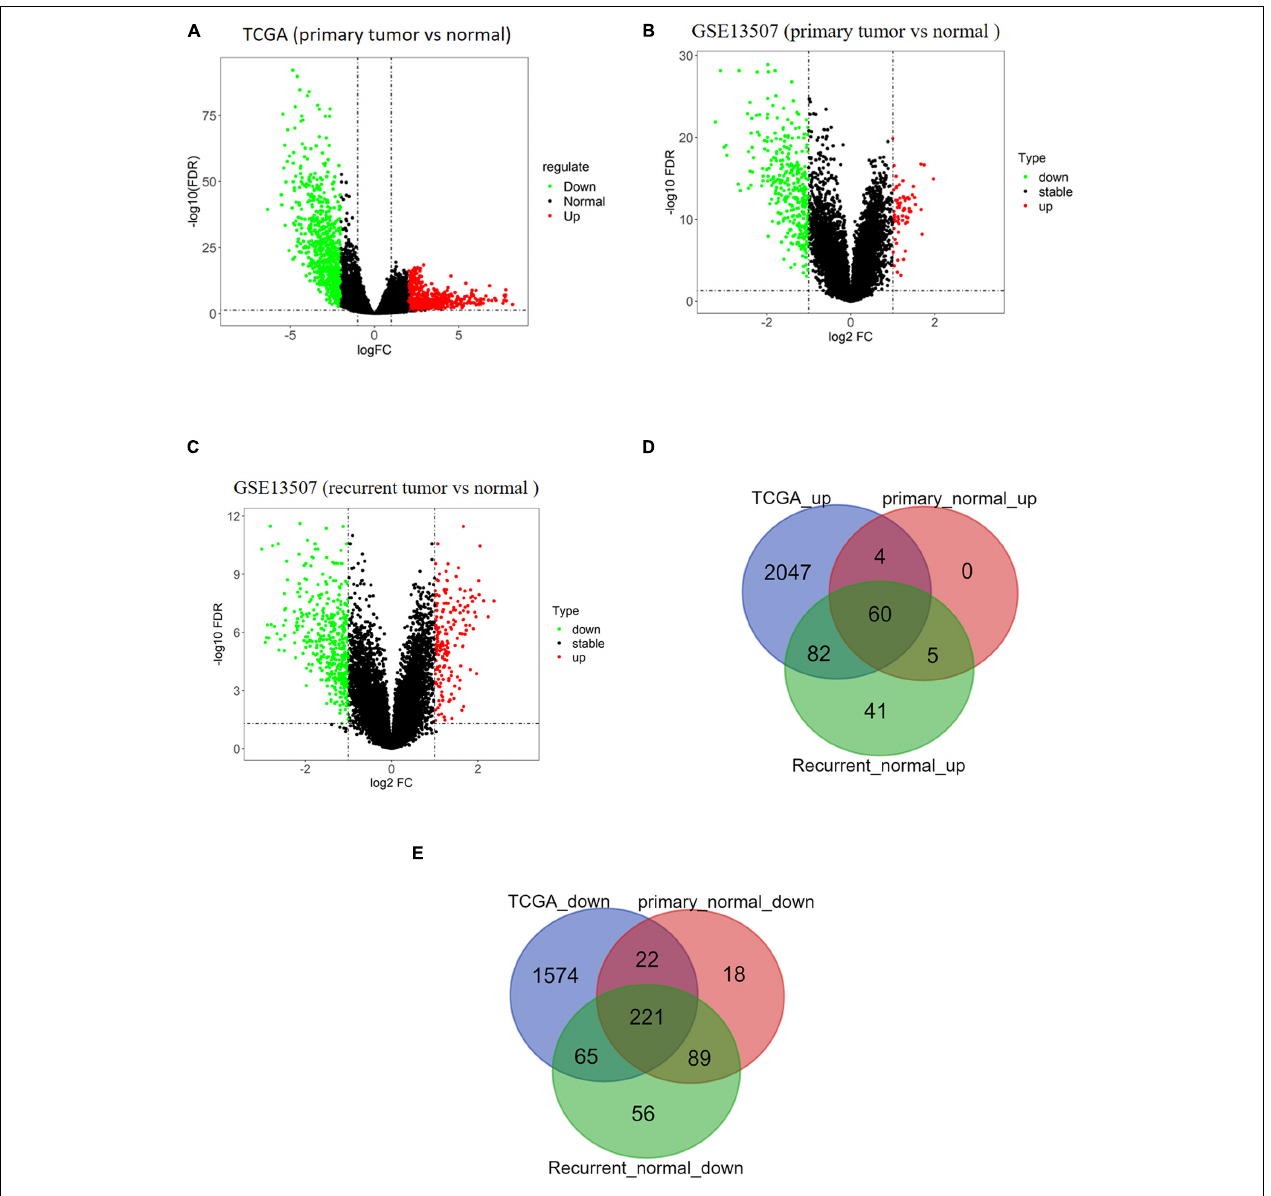
FIGURE 1 | Analysis results of differentially expressed genes (DEGs) based on public databases. (A) Volcano map of DEGs of tumor/normal samples in The Cancer Genome Atlas (TCGA) data set, in which green dots represent downregulated genes and red dots represent upregulated genes. (B) Volcano map of DEGs of primary tumor/normal samples in GSE13507 data set, in which green dots represent downregulated genes and red dots represent upregulated genes. (C) Volcano map of DEGs of recurrent tumor/normal samples in GSE13507 data set, in which green dots represent downregulated genes and red dots represent upregulated genes. (D) Venn diagram of upregulated genes of TCGA data set and GSE13507 data set. The blue circle represents DEGs from TCGA, and red and green circles represent DEGs from GSE13507. (E) Venn diagram of downregulated genes of TCGA data set and GSE13507 data set. The blue circle represents DEGs from TCGA, and red and green circles represent DEGs from